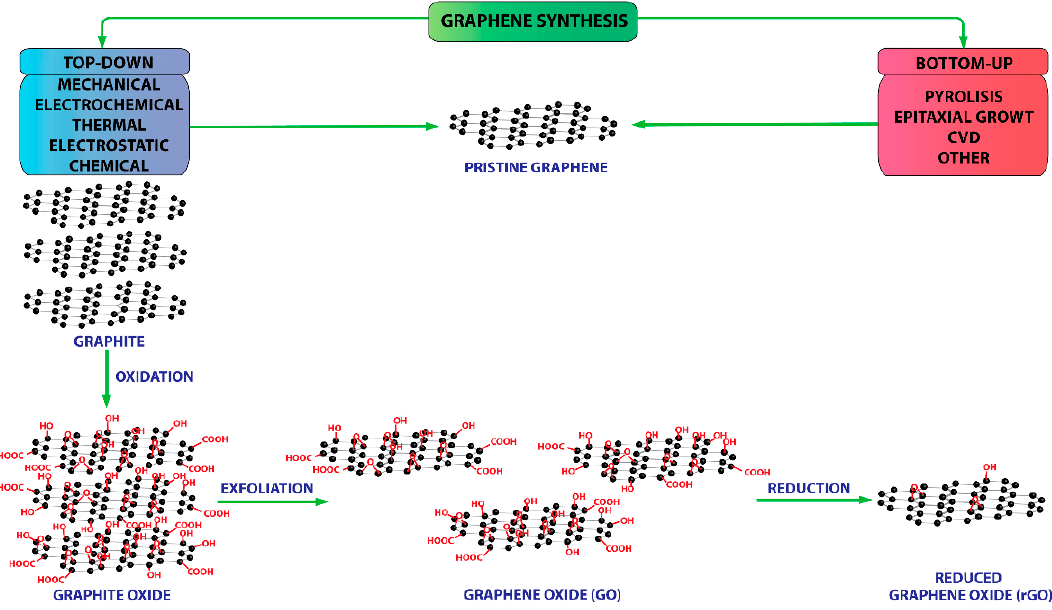
Figure 6. Top-down and bottom-up synthesis schematics of graphene. (Reprinted from [110], Copyright (2017), MDPI.)